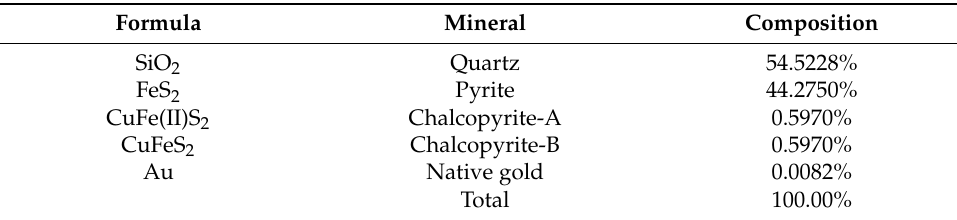
Table 1. Composition of the feedstock mineral for the process simulation.